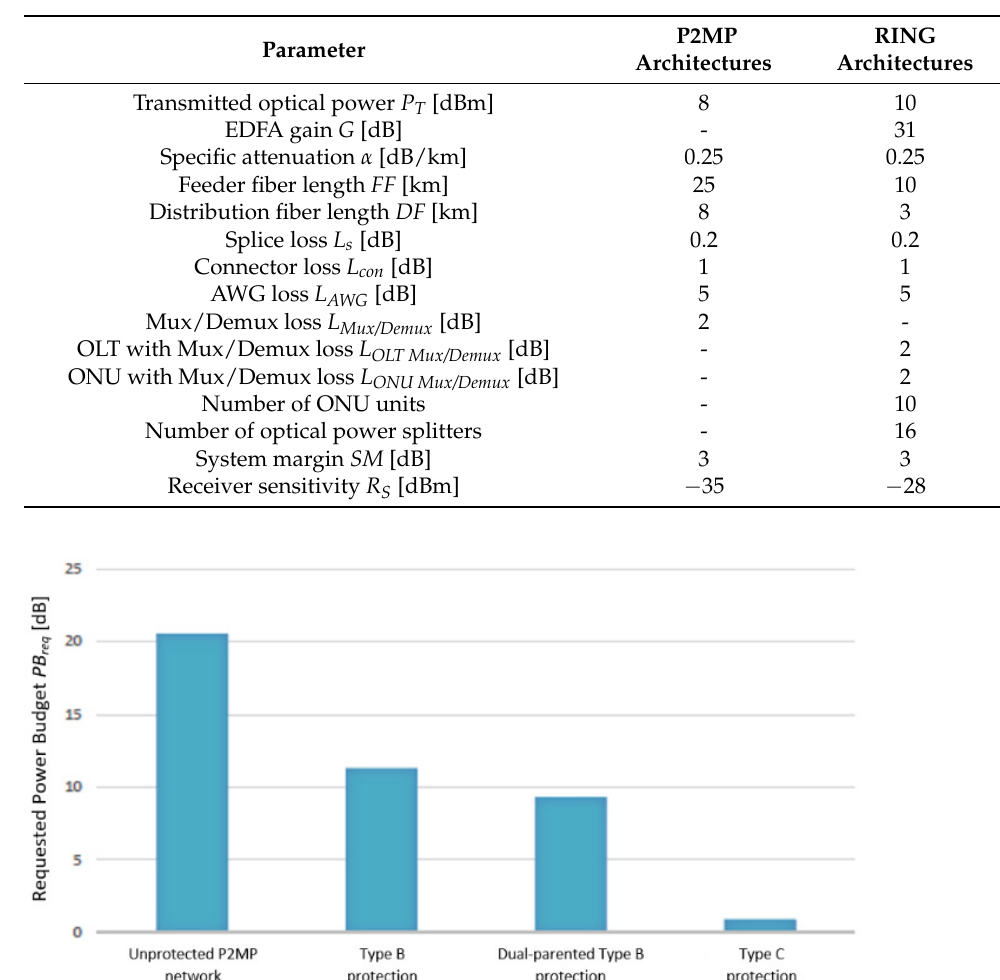
Table 2. Specific parameters’ values for power budget calculations in WDM-PON networks.